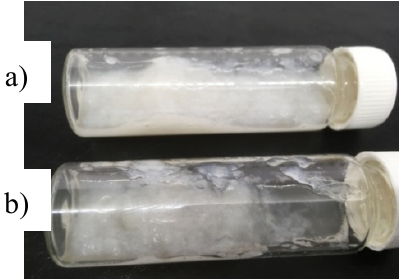
Figure 1. Appearance of the neat dispersion containing 0.5% of bacterial cellulose BC ( a ) and the same dispersion after sonication ( b ).